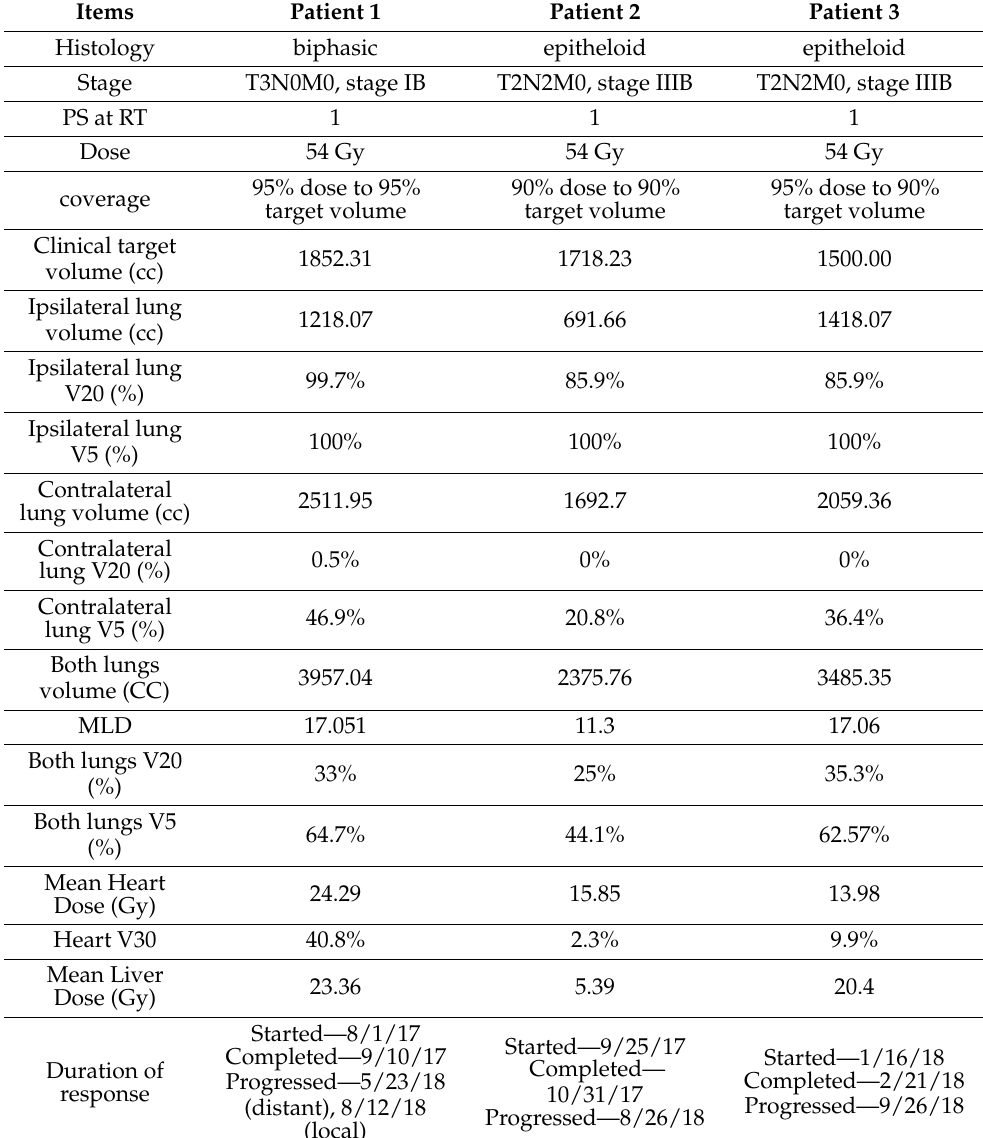
Table 2. Patient and tumor characteristics, treatment parameters, and